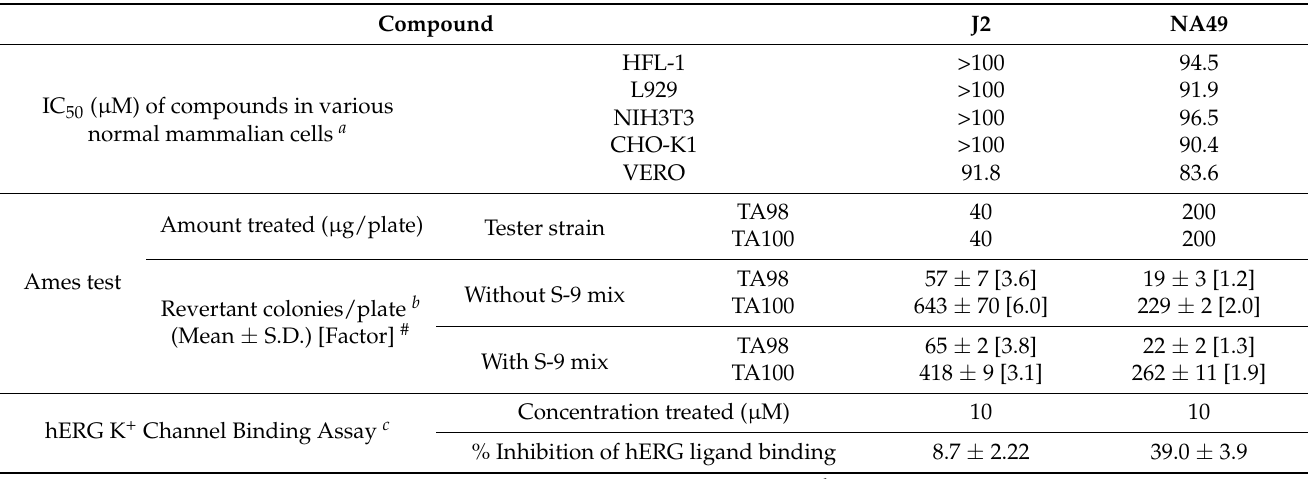
Figure 1. Structural changes of SW15, J2, and NA49. Structural changes of NA49, which is more druggable than SW15 and J2. Table 1. Toxicity of J2 and